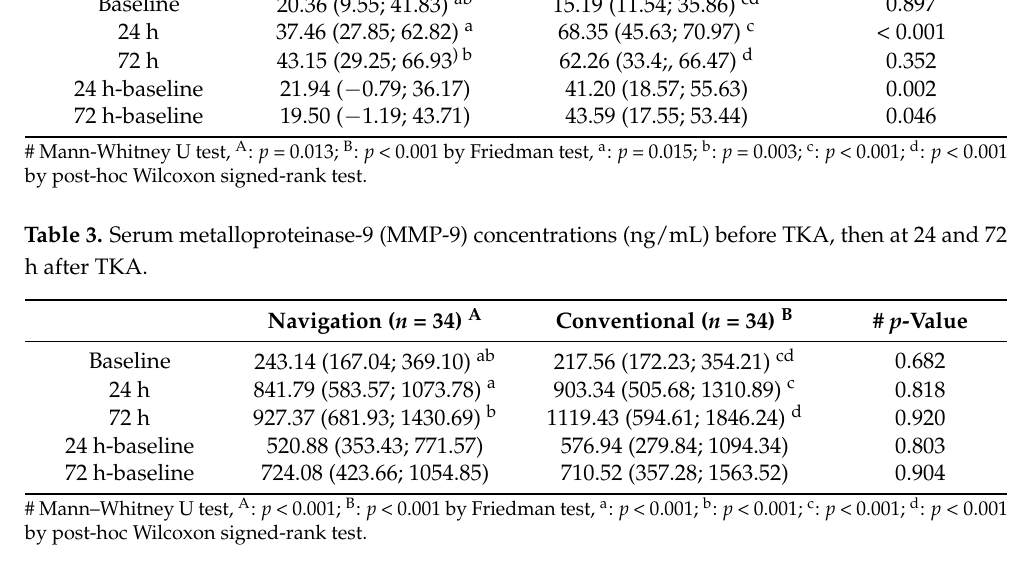
Table 4. Serum C-reactive protein concentrations (ng/mL) before TKA, then at 24 and 72 h after TKA.